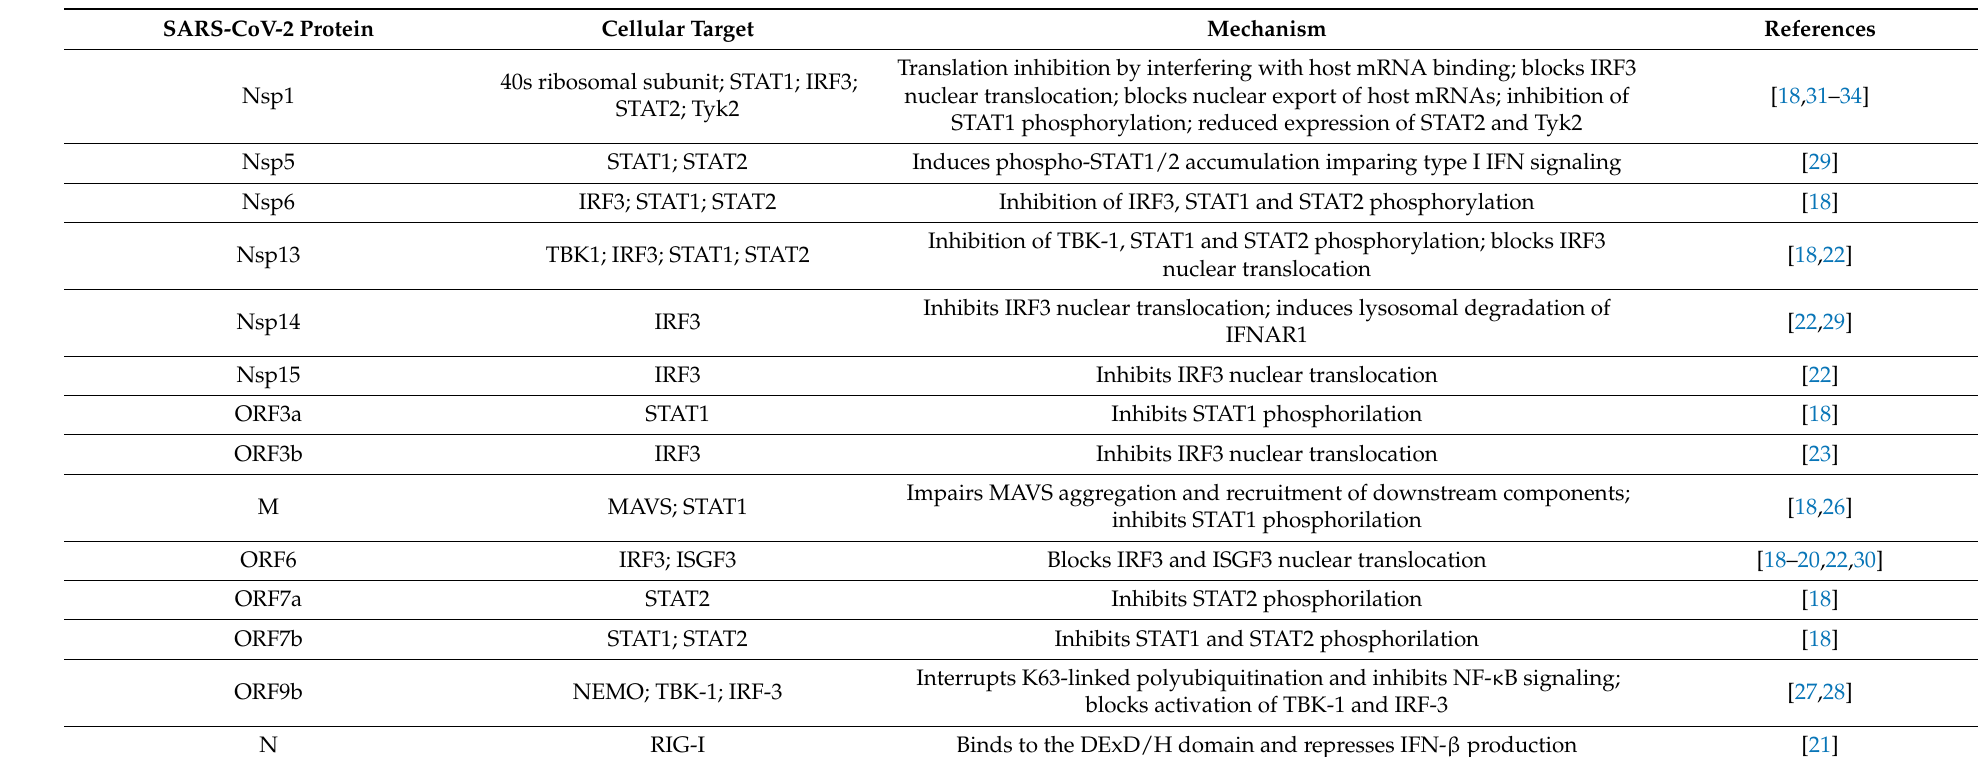
Table 1. Antagonism of Type-I IFN response by SARS-CoV-2